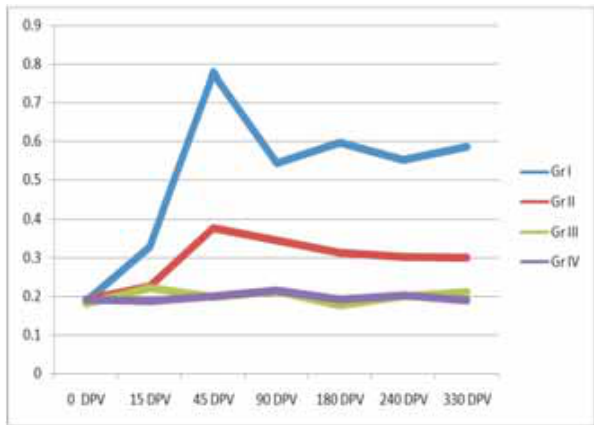
Figure-5: Graph for Nitric oxide test depicting nitric oxide level at different intervals during the study period.